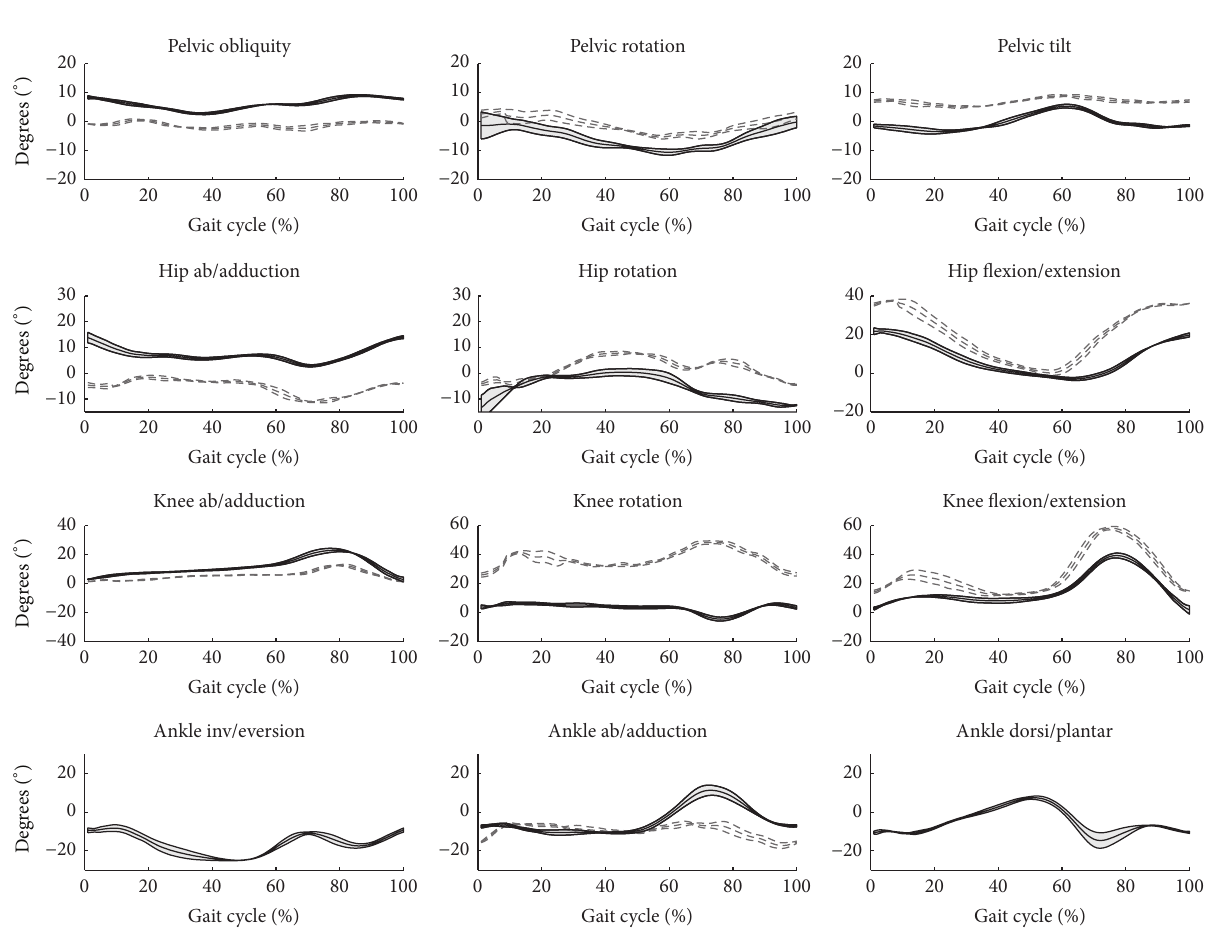
sets are comparable. Both methods are affected by soft